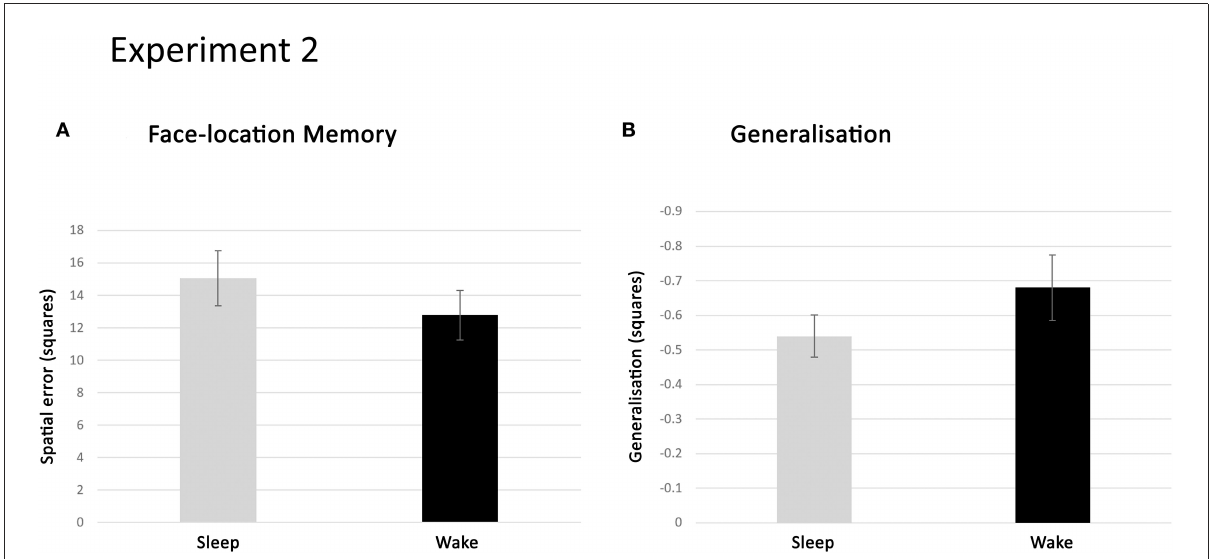
FIGURE6 Results of experiment 2. (A) Spatial error in face location retrieval, in the sleep and sleep-deprived conditions, expressed as the number of positions away from the correct location, averaged across retrieved faces and subjects in each condition. Memory performance in the two conditions was similar (n.s.). (B) Generalisation in the sleep and sleep-deprived condition expressed as the spatial deviation (in number of positions) of face-location retrieval towards the hotspots, averaged across retrieved faces and subjects in each condition. Generalisation occurred to a similar extent in the two conditions (n.s.). Error bars represent the standard error of the mean.